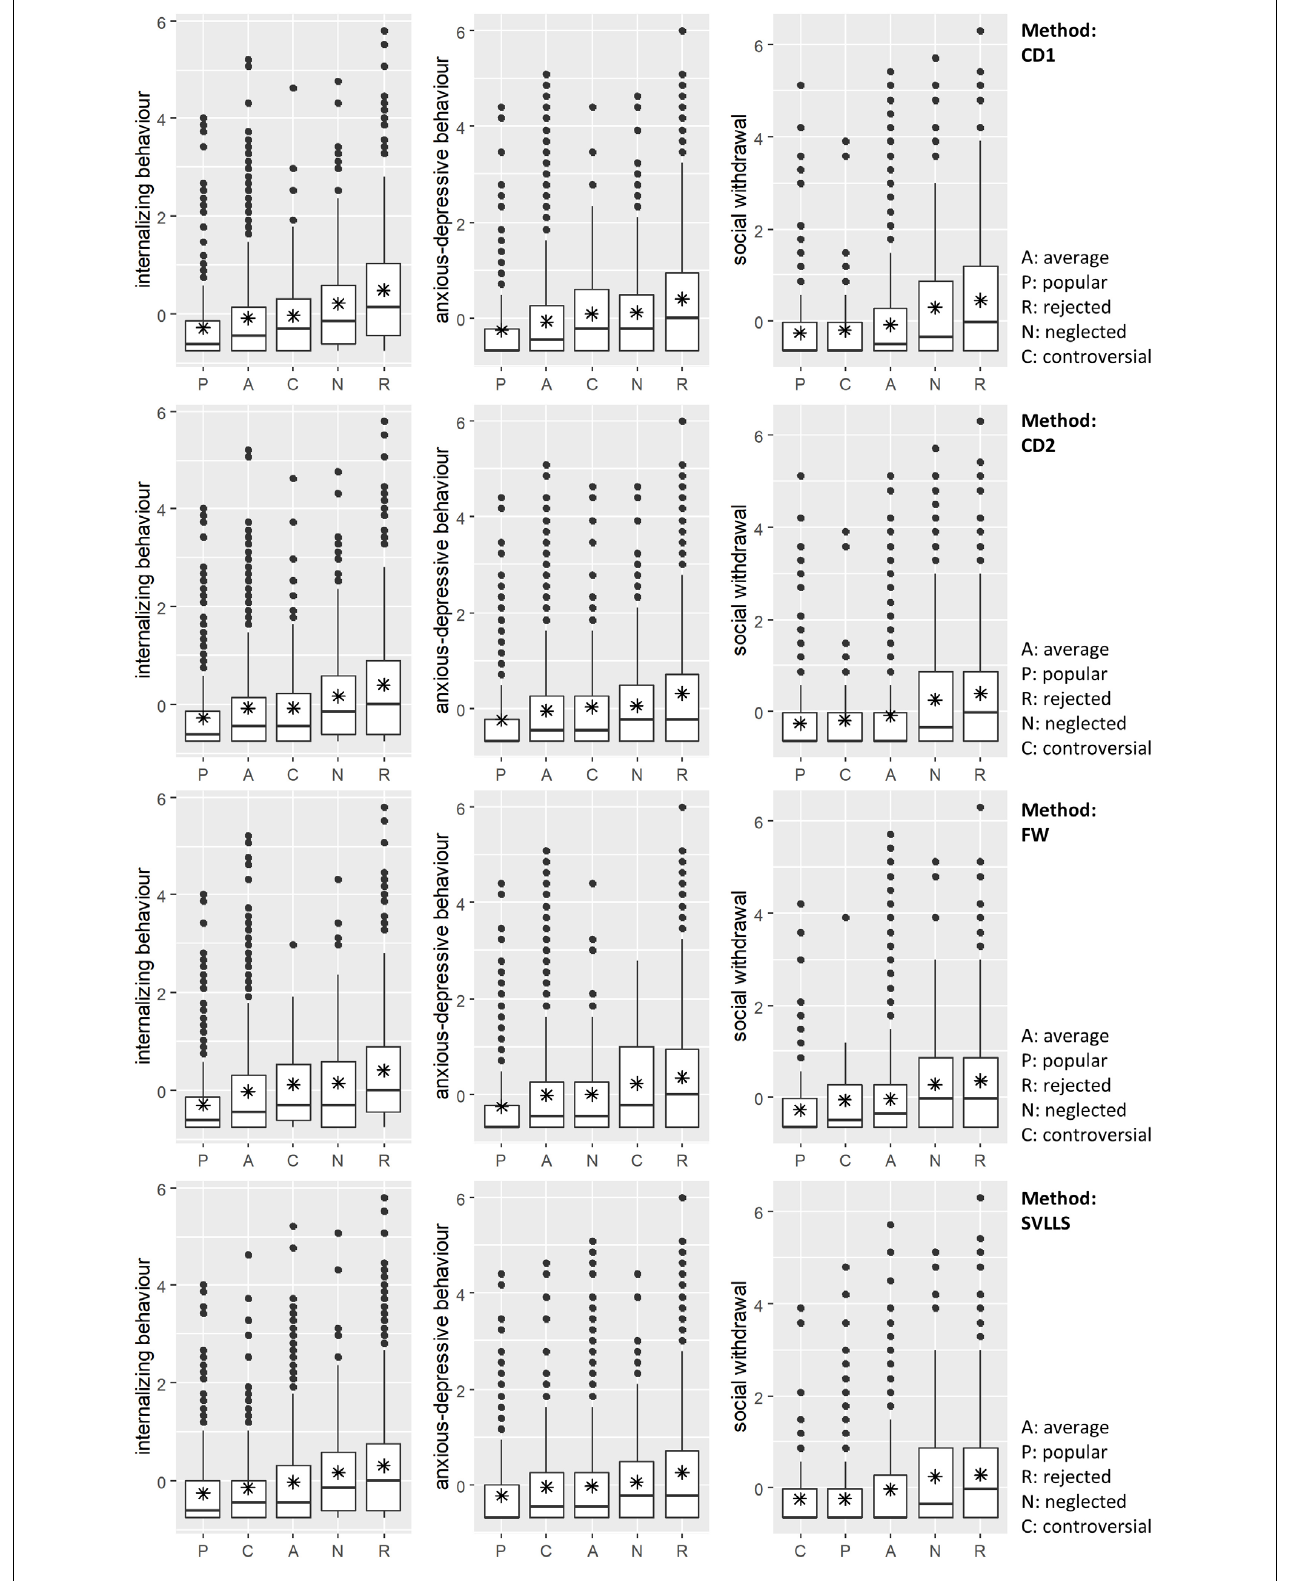
FIGURE 2 | Broadband scale of internalizing behavior and narrowband scales of internalizing behavior (anxious-depressive behavior and social withdrawal) by sociometric groups (boxplots in ascending rank order).